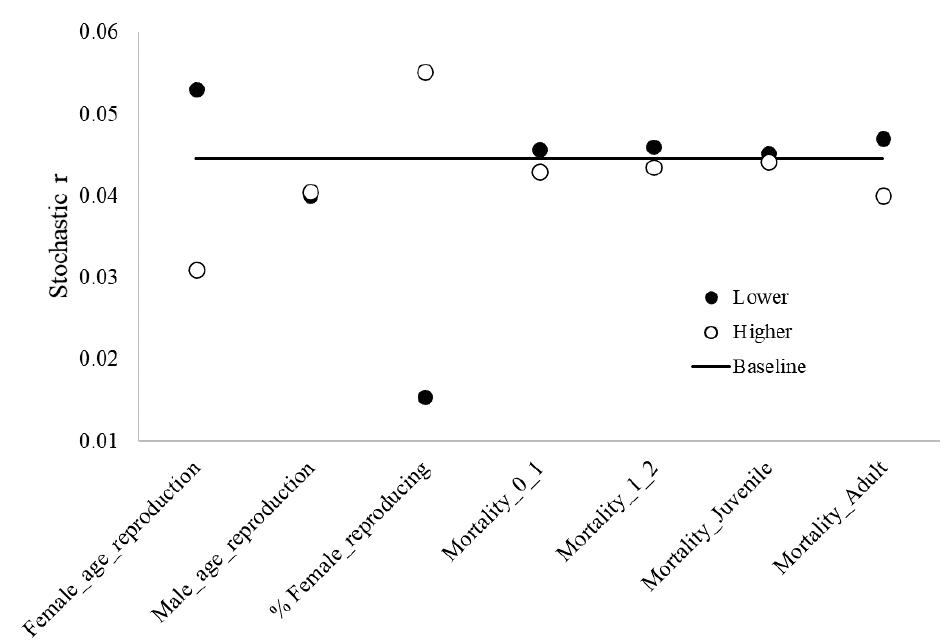
Figure 3. Results from sensitivity analysis, highlighting the baseline stochastic r values and lower and higher values regarding different reproduction and mortality parameters of blue-and-yellow macaw ( Ara ararauna ). Female_age_reproduction: age of first offspring females, Male_age_reproduction: age of first offspring males, % _reproducing females: % reproducing adult females; Mortality_0_1: mortality rates from age 0 to 1, Mortality_1_2: mortality rates from age 1 to 2, Mortality_Juveniles: mortality rates for juveniles, Mortality_Adult: mortality rates for adults.